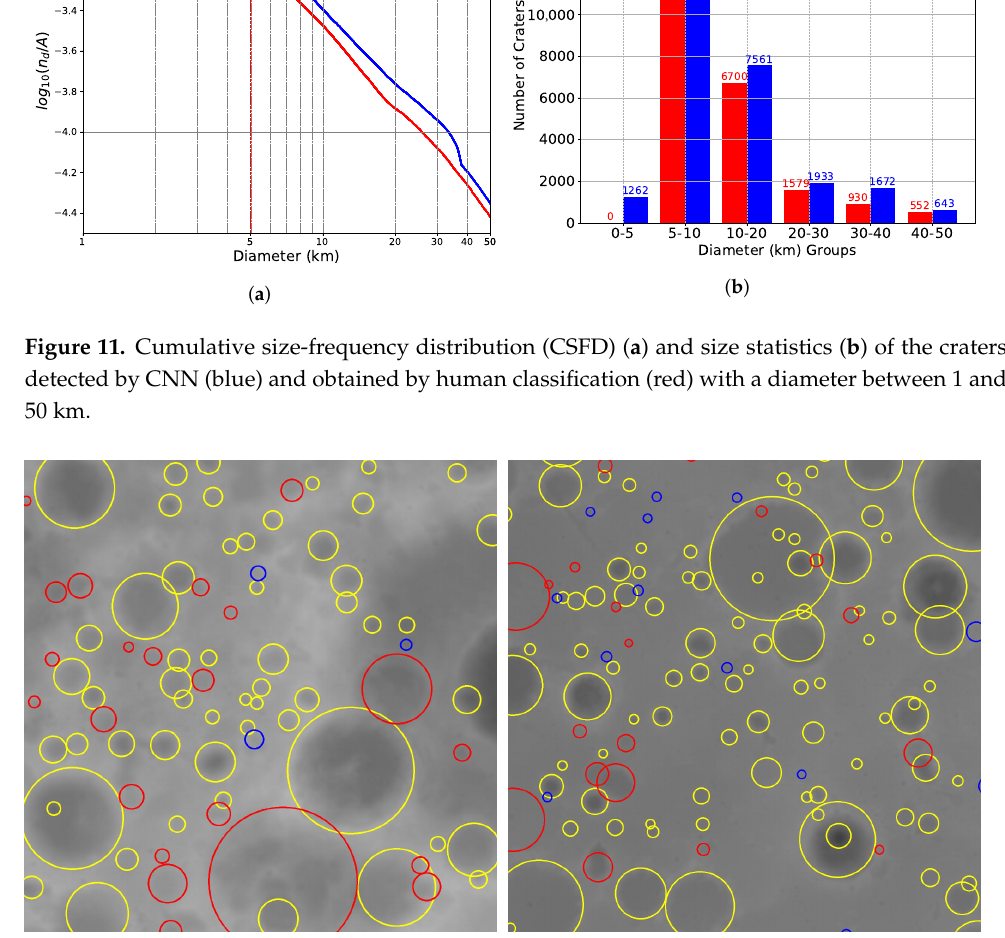
Figure 12. Example results of our method on the test set. Yellow circles represent detected craters that were successfully matched to the ground-truth targets. Red circles are newly identified craters that are not labeled on the current datasets. Blue circles represent the ground-truth craters undetected by our method. Table 4. Comparison of two existing lunar crater catalogs and our extended lunar crater catalog for different diameter ranges over the Moon within the latitude range from ´ 60 ˝ to 60 ˝